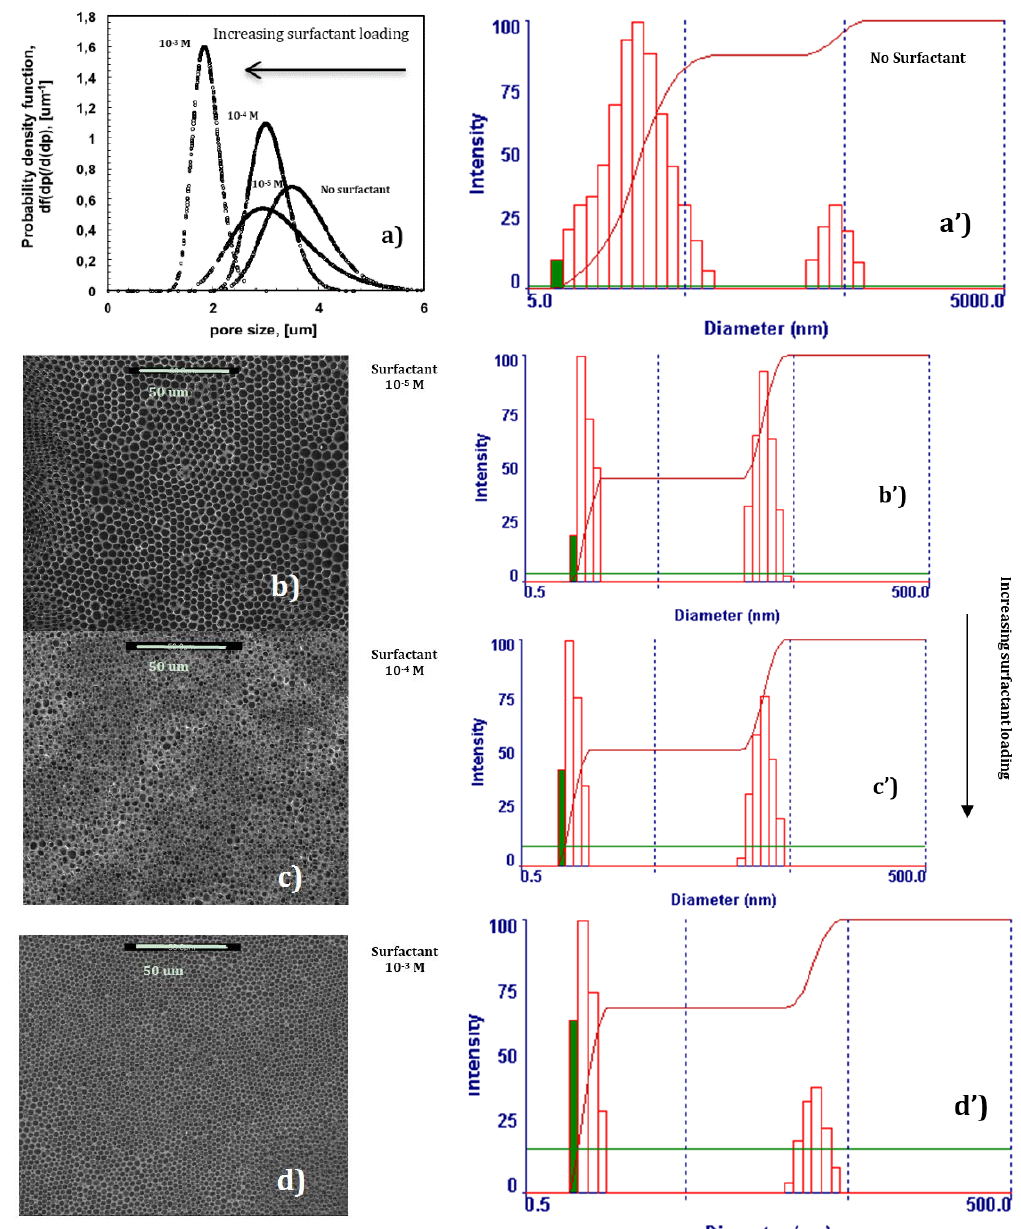
Figure 4. Changes in the pore size and distribution with rising content of surfactant ( a ); Effects of surfactant/alcohol complex on membrane morphology (SEM micrographics ( b – d ) and formation of aggregates in precursor polymeric solutions (Dynamic Light Scattering ( a’ – d’ )).